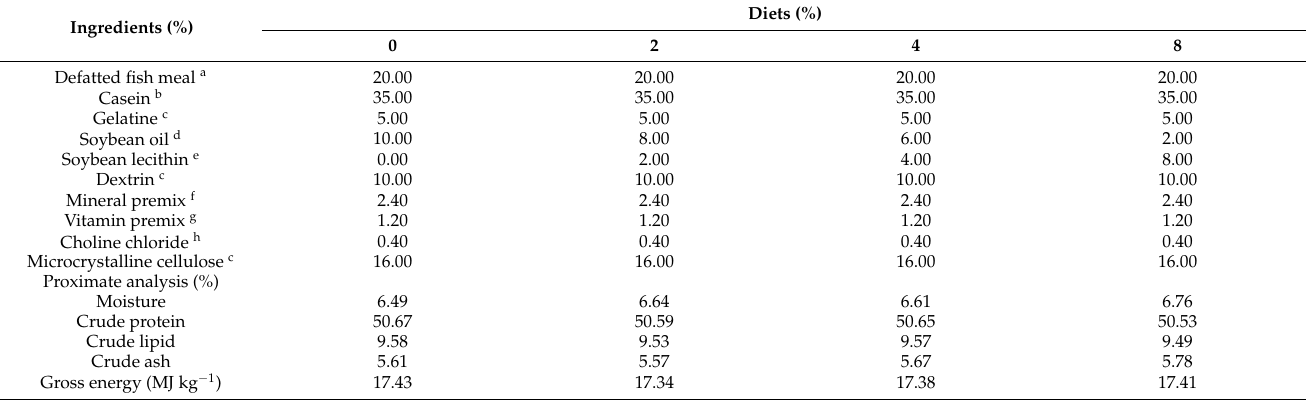
Table 1. Ingredient and proximate composition of the experimental diets (on dry weight